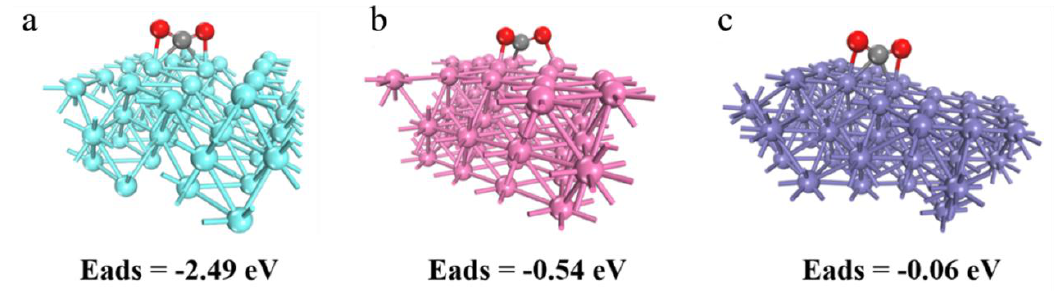
Figure 11. Side views of the optimized geometric structures of CO 2 adsorption on: ( a ) (101) plane of Ti; ( b ) (111) plane of Al; ( c ) (110) plane of Fe. Gray and red balls stand for the C and O atoms, respectively.